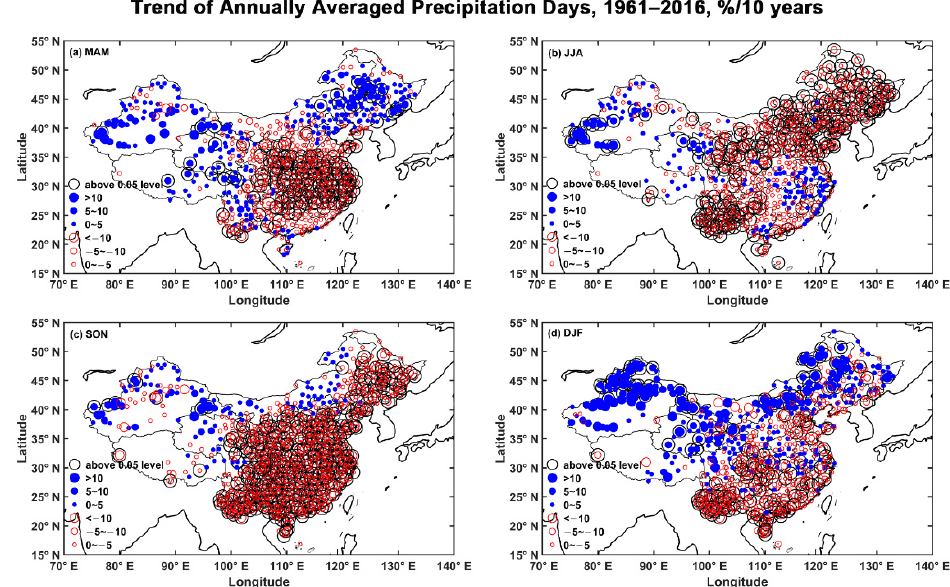
Figure 6. The decadal trend of the relative change of seasonally averaged precipitation days (unit: % / 10 years) in ( a ) spring, ( b ) summer, ( c ) autumn, and ( d ) winter at 635 ground stations.